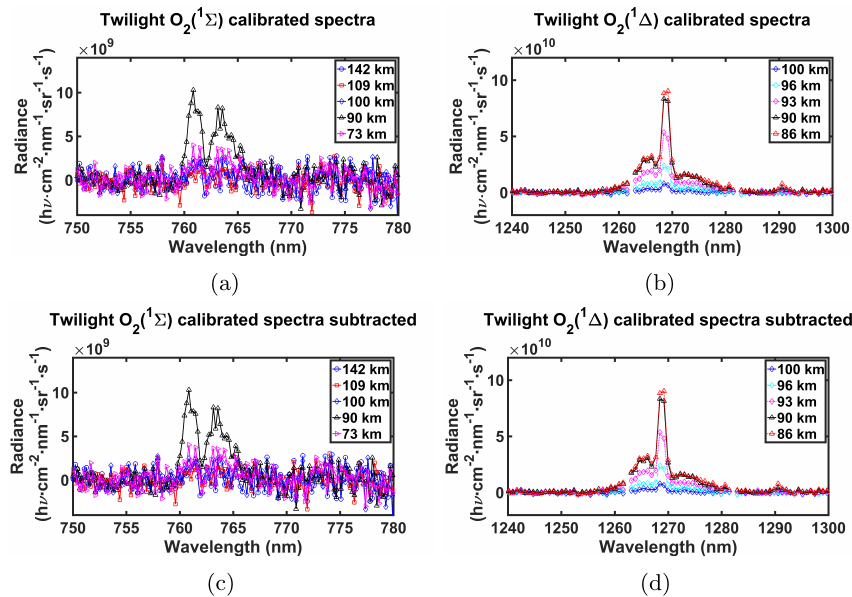
Figure 3. Examples of the twilight-calibrated spectra and the spectra from which the background O 2 ( 3 (cid:54) g ) to O 2 ( 1 (cid:54)) absorption has been subtracted. (a) for the O 2 ( 1 (cid:54)) band on 3 February 2010; orbit number 41455; mean latitude of 78.0 ◦ N, mean longitude of 226.5 ◦ E. (b) as (a) but for the O 2 ( 1 (cid:49)) band. (c) as (a) but with background subtracted. (d) as (b) but with background